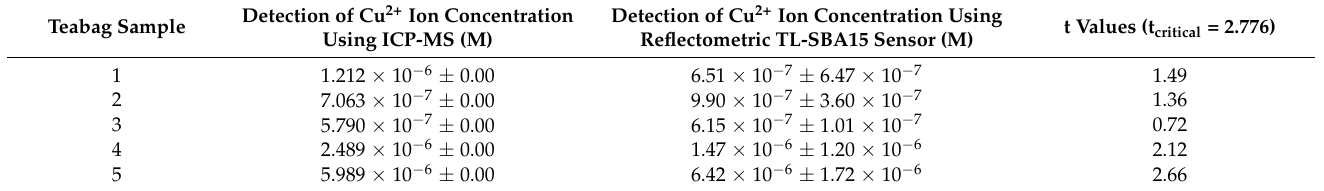
Table 2. Validation of the constructed Cu 2+ ion optical sensor with ICP-MS as a reference method for the detection of Cu 2+ ion concentration in teabag samples spiked with standard Cu 2+ ion in the concentration from 6 × 10 − 7 M to 6 × 10 − 6 M ( n = 3).